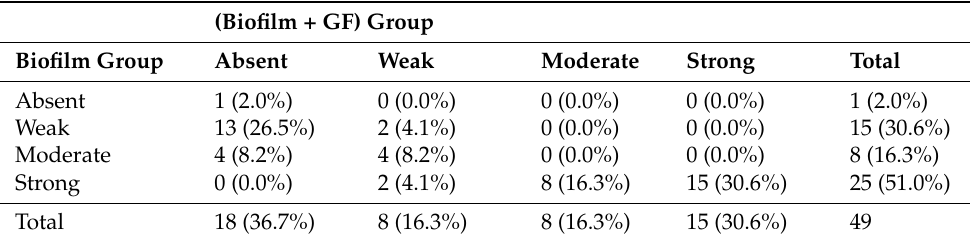
Table 2. Percentages and numbers of Absent, Weak, Moderate, and Strong classifications of clinical isolates of MRSA in the biofilm and biofilm with GF groups.